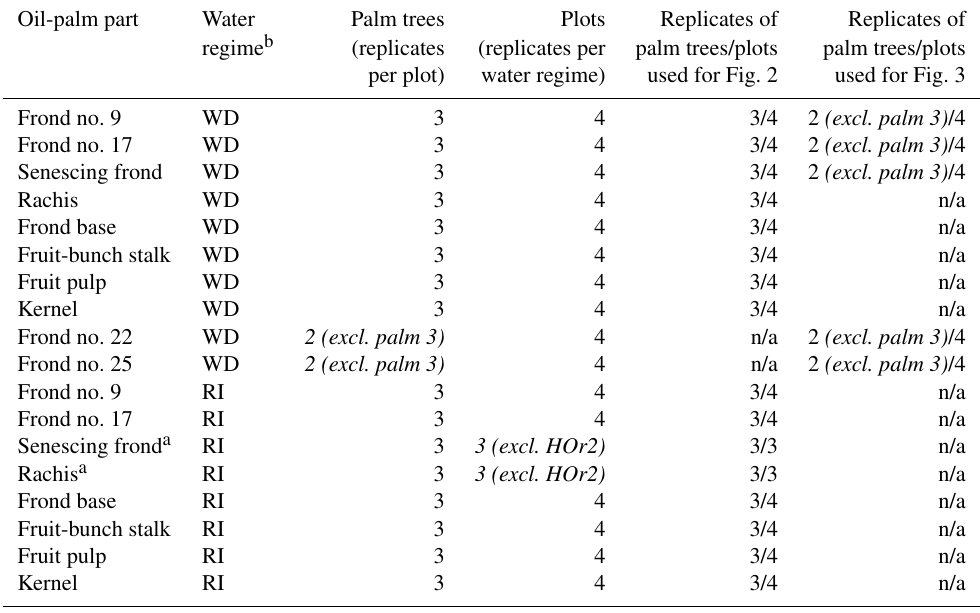
Frond base RI Fruit-bunch stalk RI Fruit pulp RI Kernel RI